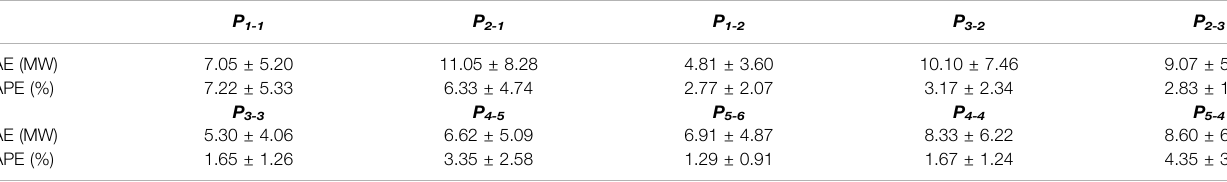
TABLE 3 | The AE and APE statistics of the generated reactive data (IEEE 39-bus